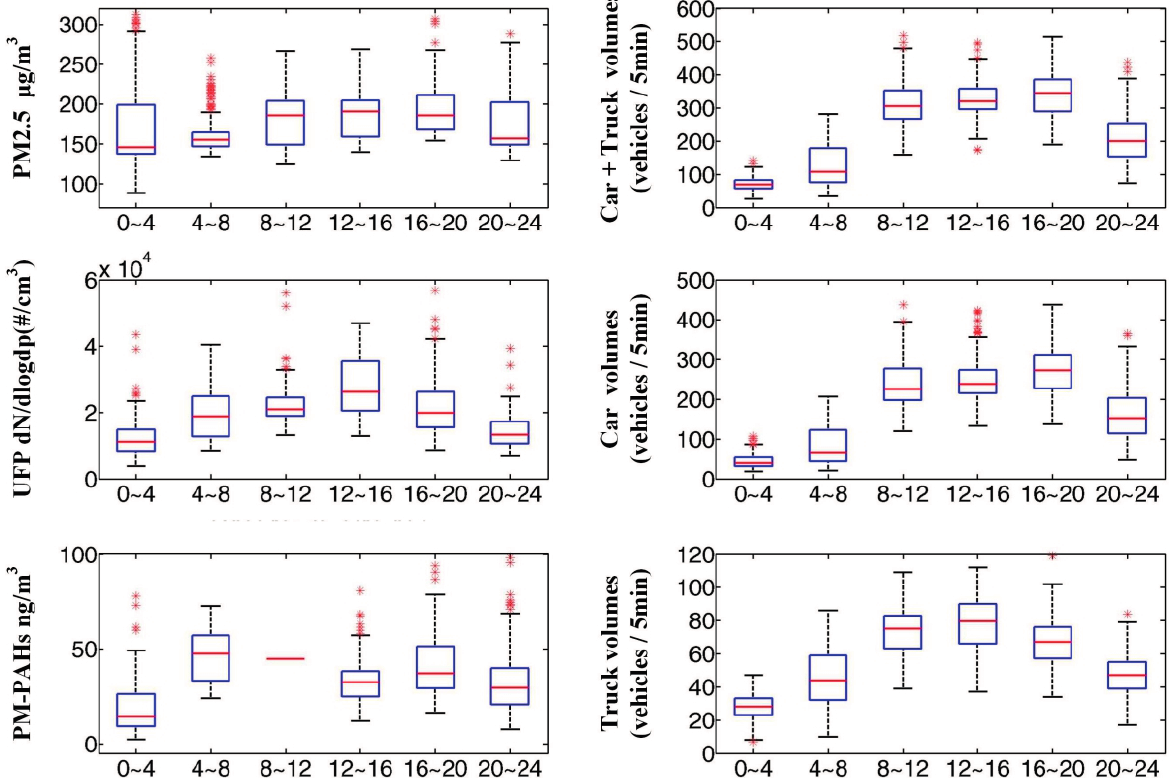
Figure 3. Diurnal pattern of the traffic volume, PM2.5, UFP, and PM-PAHs in the police station during different working shifts. The box represents the 25th and 75th percentiles while the whiskers represent the 5th and 95th percentiles.